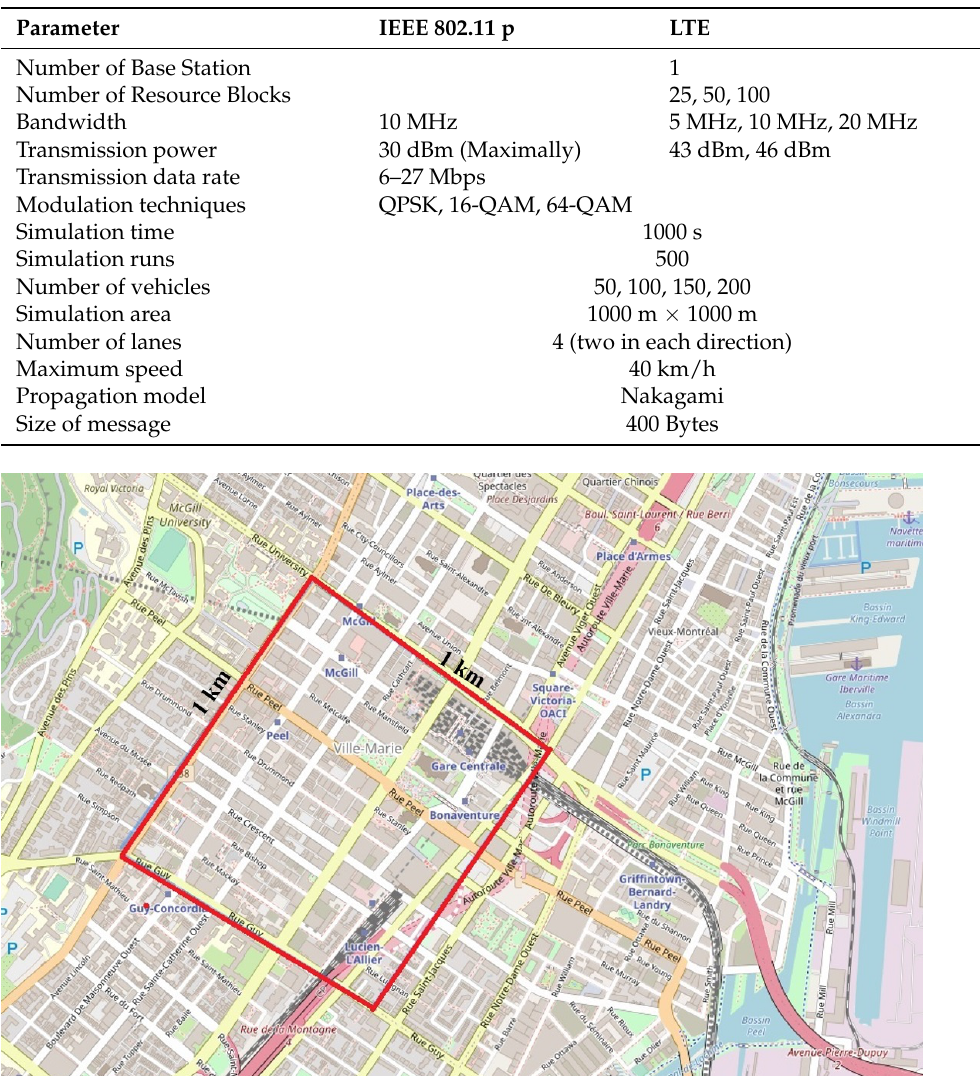
Table 1. Simulation parameters and corresponding values.